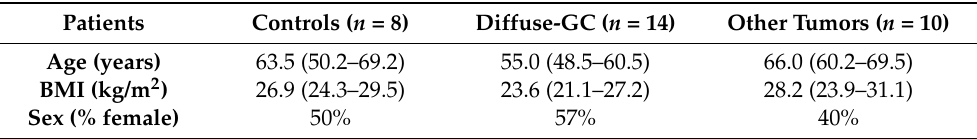
Table 1. Summary characteristics of patients (median and interquartile range) without cancer (controls), with diffuse-gastric adenocarcinoma, with other tumors that metastasis in the peritoneal cavity. Age and BMI of case groups were compared with controls using Mann–Whitney U test without statistical